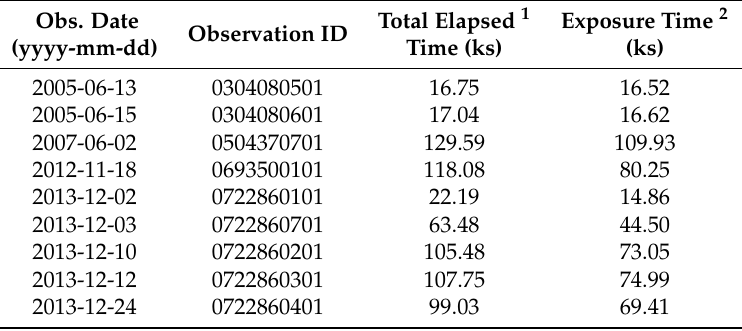
Table 1. Observation Log of XMM-Newton data for Blazar H 2356-309. Obs.